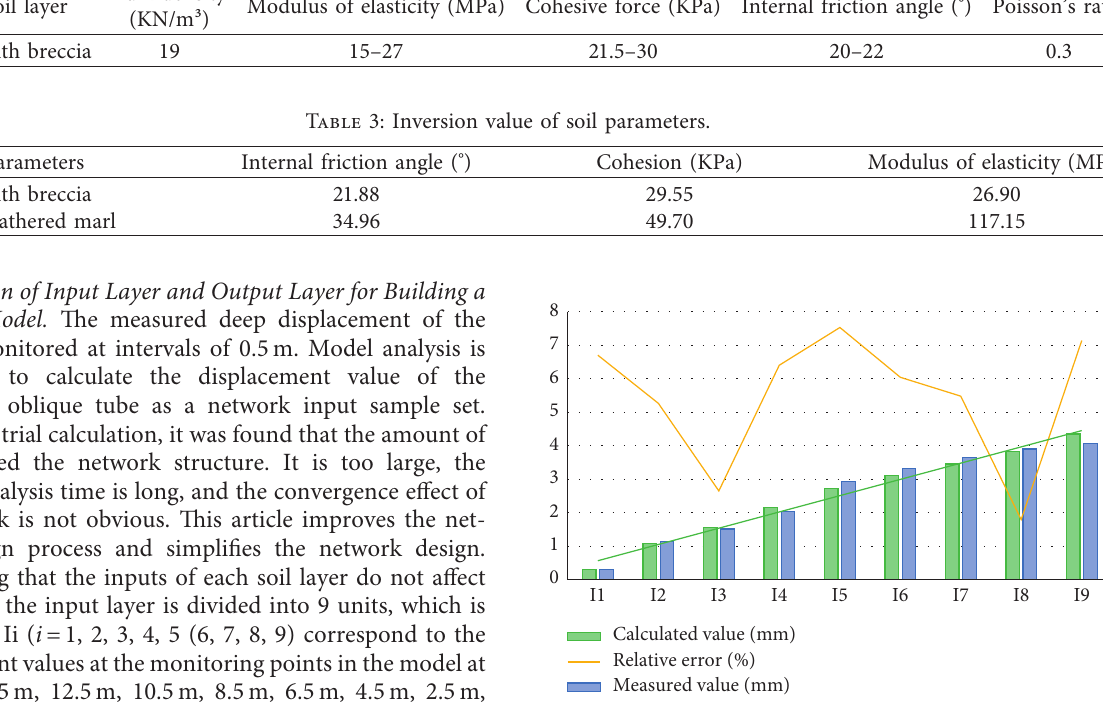
Figure 5: Analysis of the comparison between the calculated value and the measured value of the displacement at different depths at the monitoring